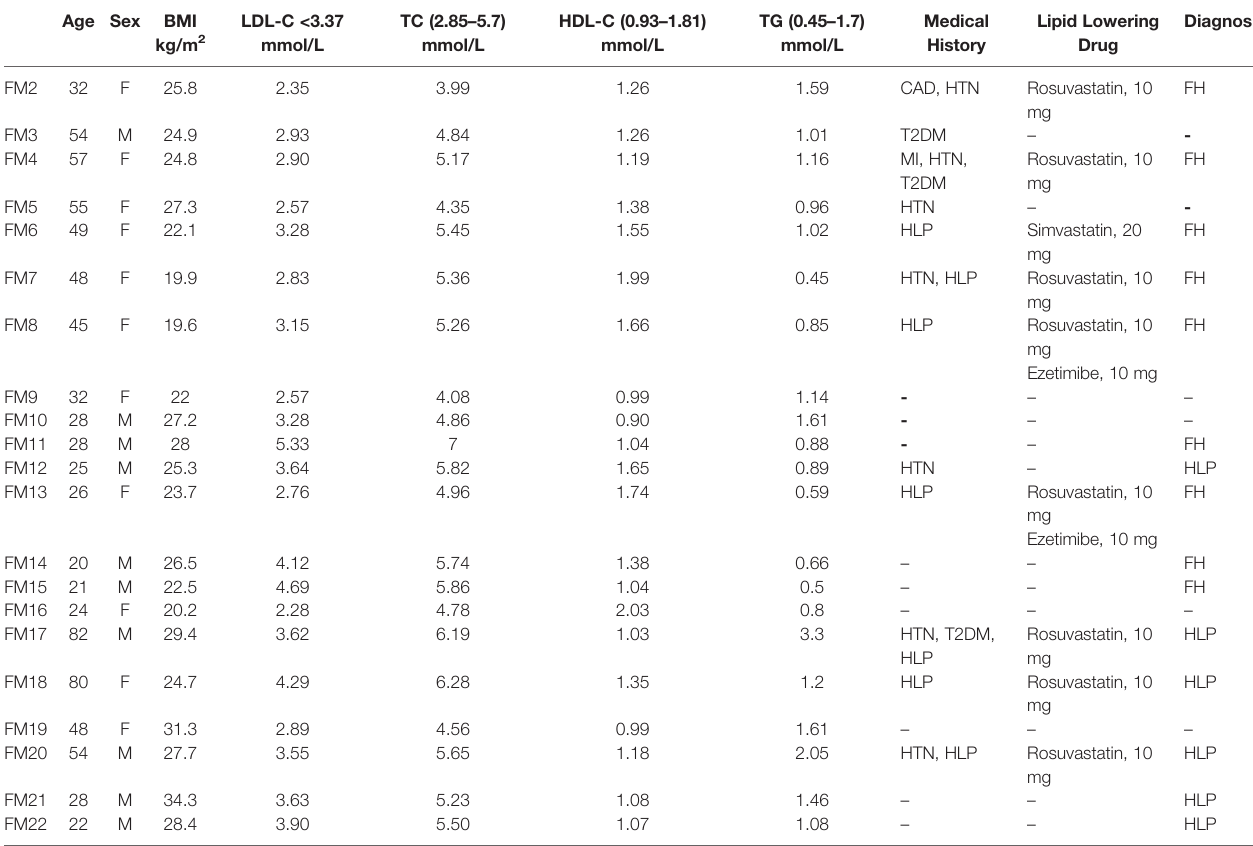
TABLE 1 | Clinical characteristics of enrolled FH